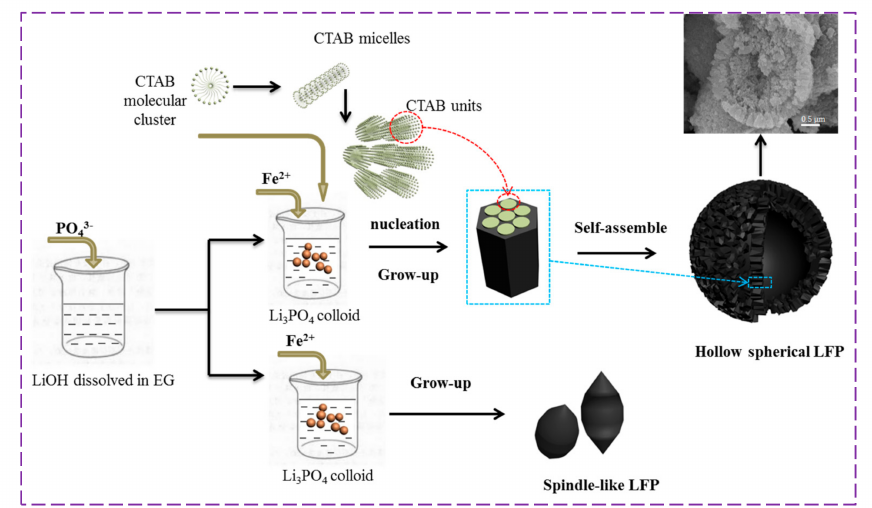
Figure 3. Schematic illustration of the formation of LiFePO 4 /C